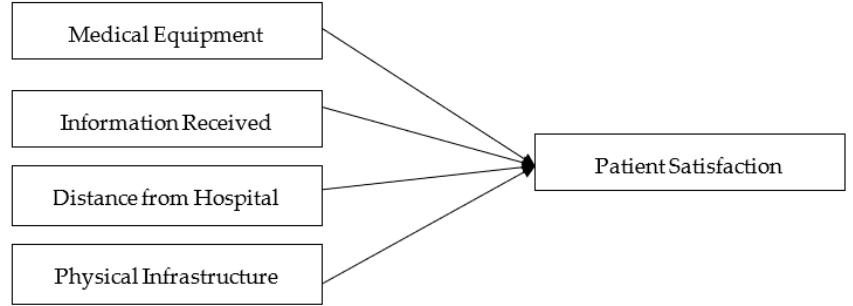
Figure 1. Conceptual framework of the study.